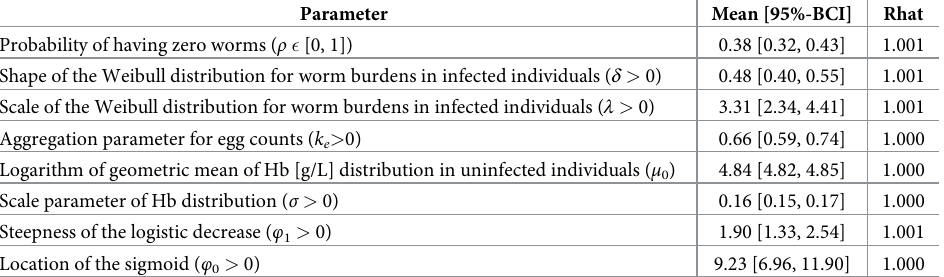
Table 2. Model parameter estimates. Estimates represent posterior distributions of model parameters. For each parameter, Rhat can be used as indicator for Markov chains convergence (at convergence, Rhat = 1). BCI = Bayesian credible interval, based on the central 95% percentiles of the posterior draws.